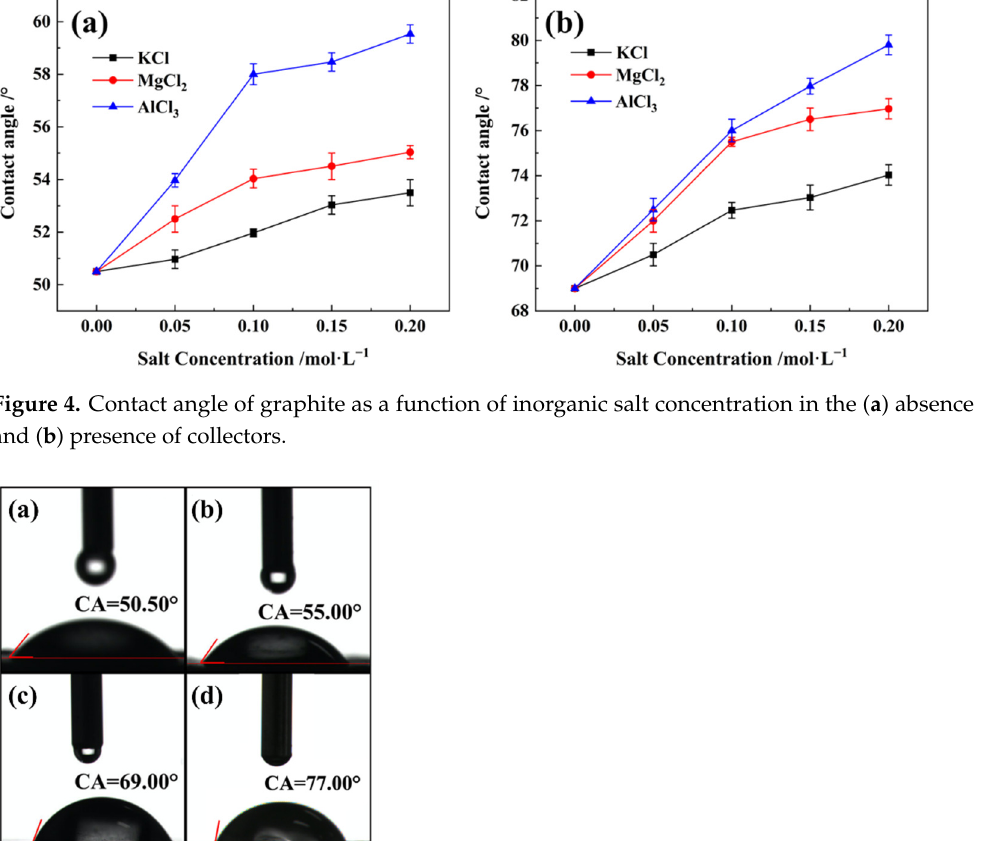
Figure 6. The effect of different inorganic salts on the zeta potential of graphite. 3.3. Effect of Salt Ions on the Properties of Foam 3.3.1. Solution Chemistry Analysis Compared to KCl, MgCl 2 and AlCl 3 will undergo a series of hydrolysis reactions in water to produce various products. The phase diagrams of Mg 2+ and Al 3+ in the solution at different pH are shown in Figure 7.